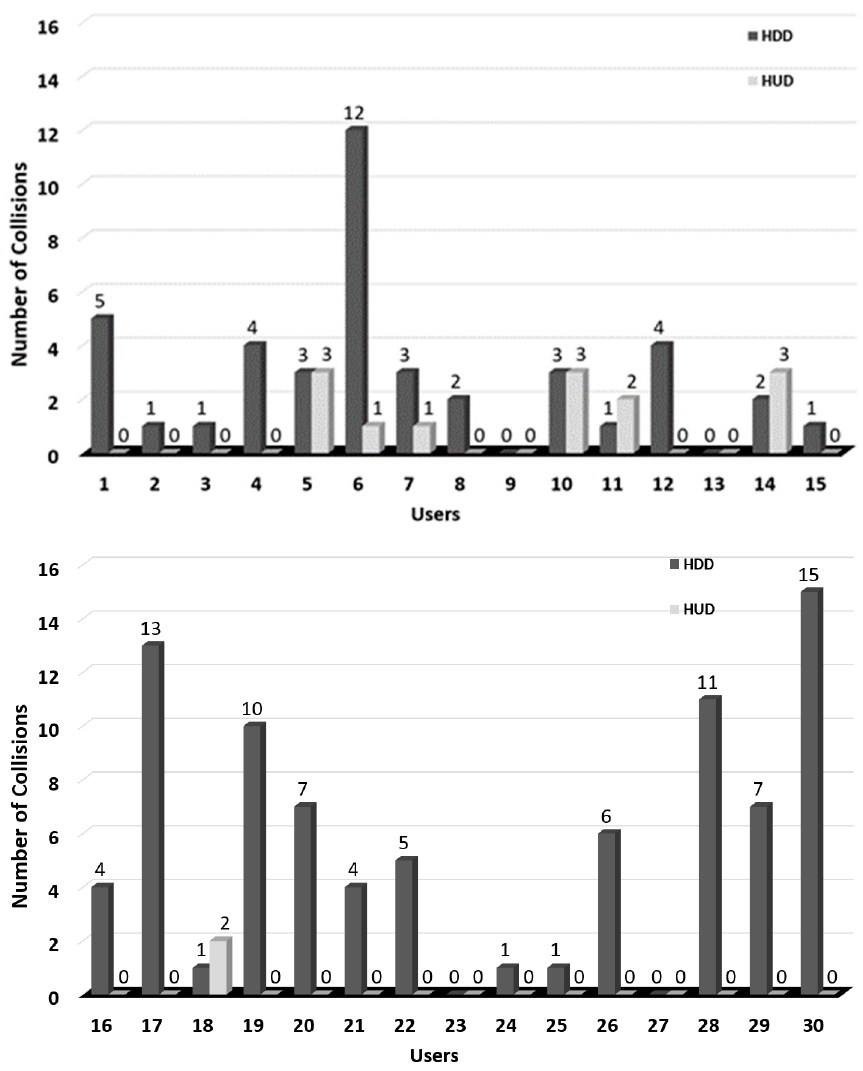
Figure 13. Number of collisions per user with and without the HUD (1–30). Upper image contains 1–15 users and the lower image contains 16–30 users.